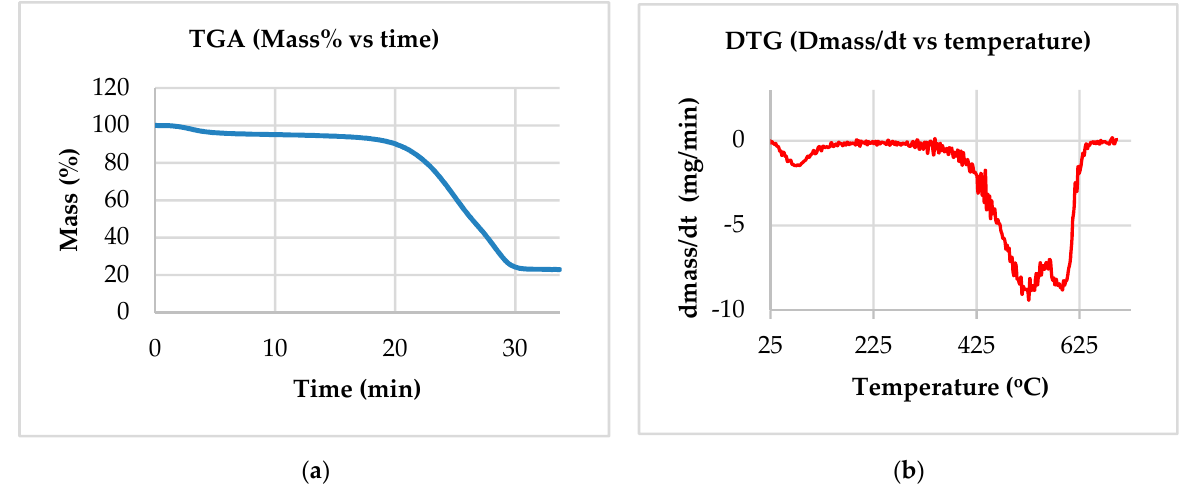
Figure 6. ( a ) Pyrolytic biochar weight loss diagram as a function of time (TGA, Air flow). ( b ) Biochar weight change rate diagram as a function of temperature (DTG, Air flow).